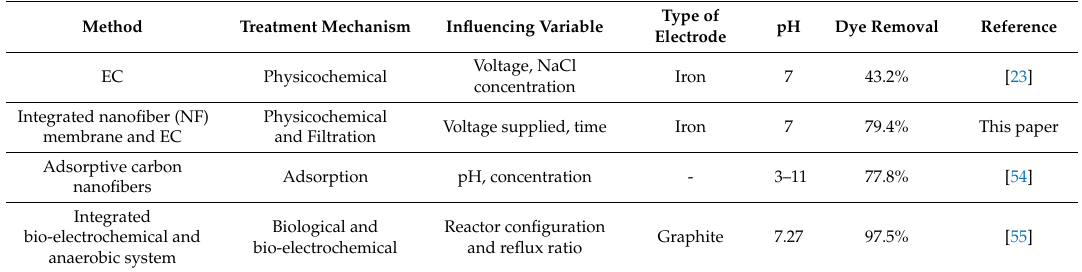
Table 3. Comparison of the proposed method and other methods of treatment of dye in